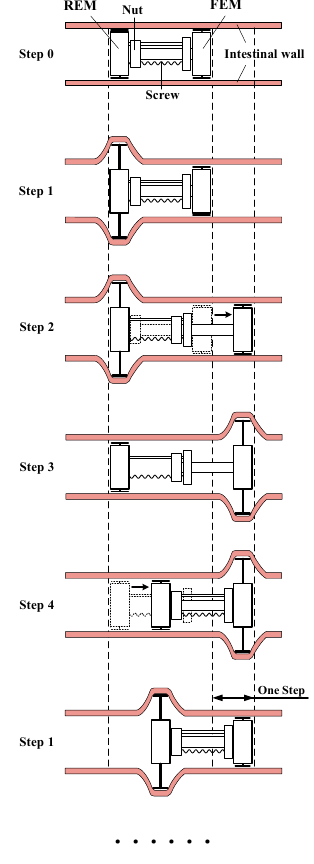
Figure 3. Locomotion principle of the inchworm-like GMR.